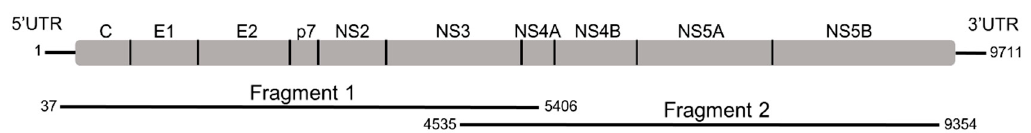
Figure 1. Generalized approach to amplify the full-length HCV genome.